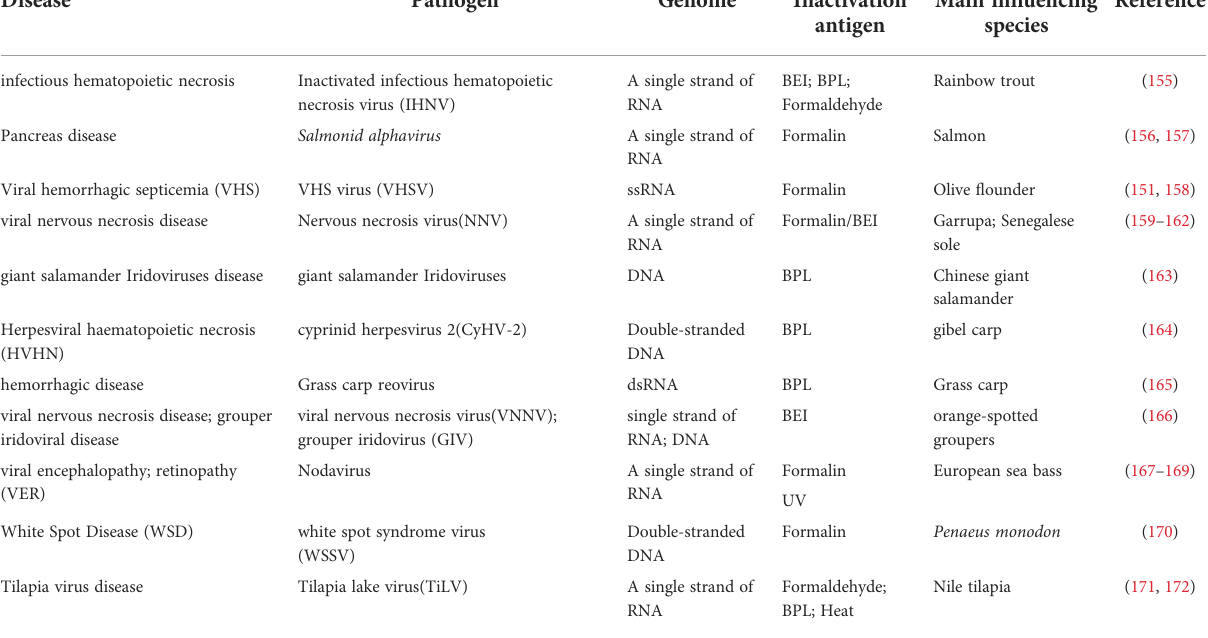
TABLE 5 Inactivated Viral